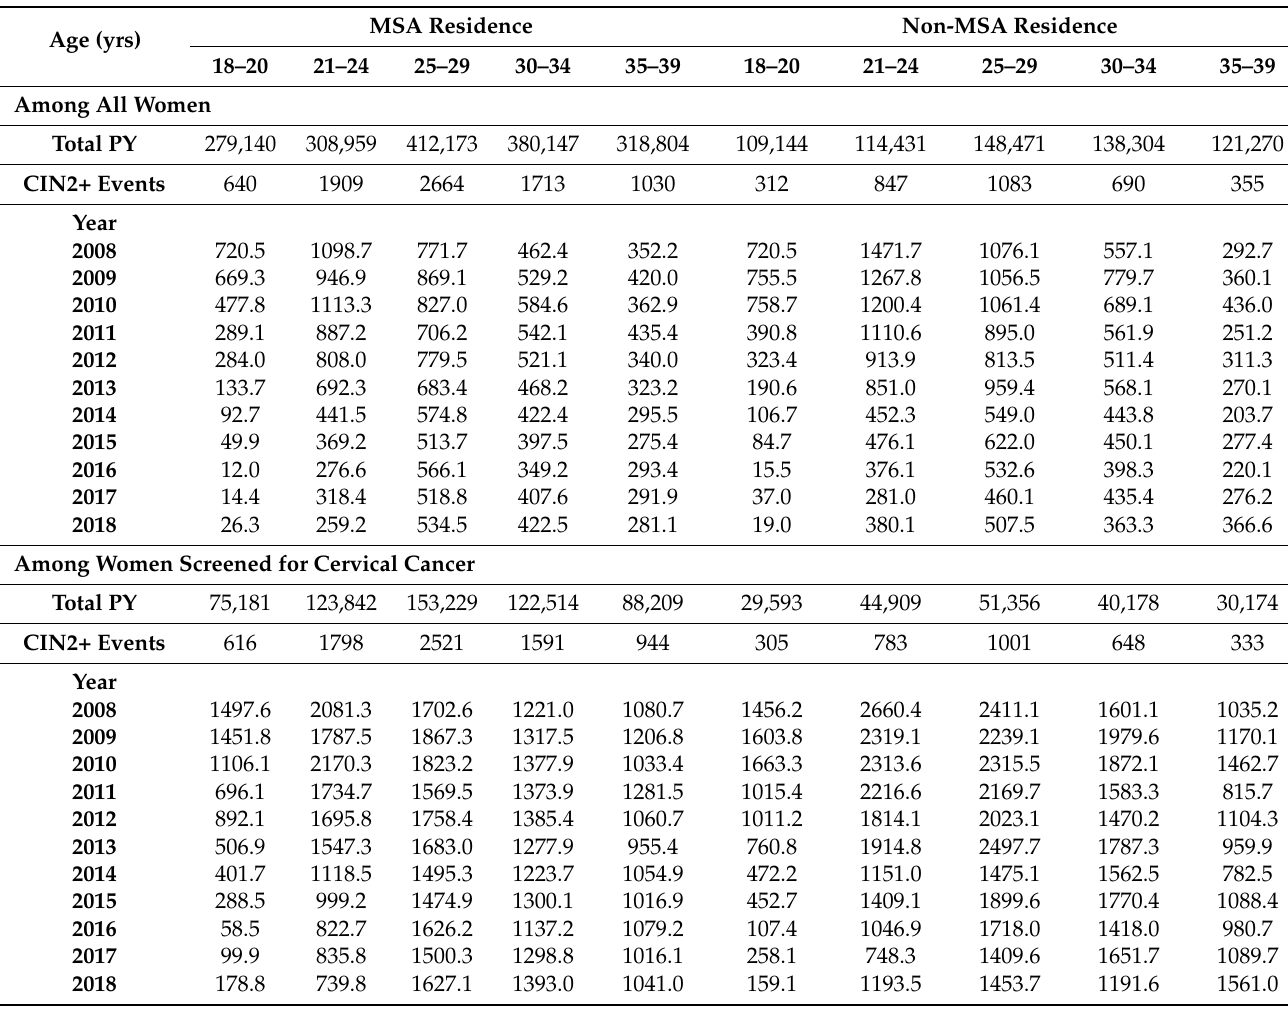
Table 1. Annual age-group-specific CIN2+ incidence per 100,000 person-years among all women enrolled in Tennessee Medicaid and the subset of women screened for cervical cancer by urbanicity, 2008–2018. Age